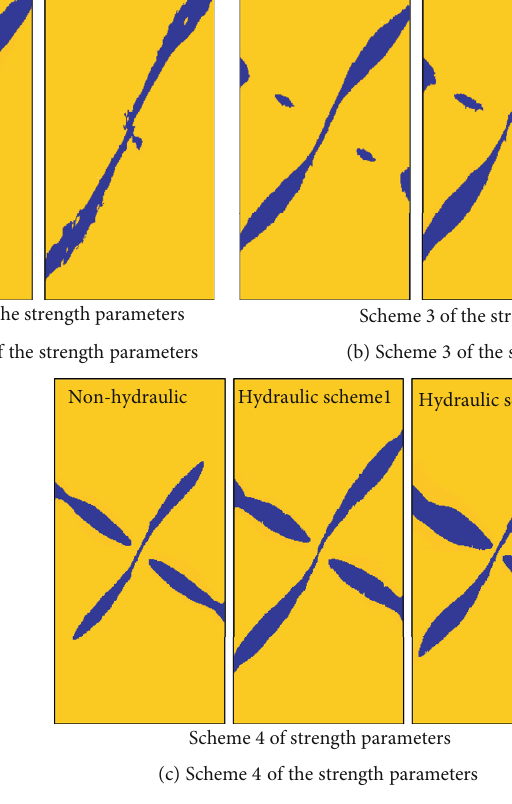
Figure 14: Crack propagation patterns under nonhydraulic and hydraulic